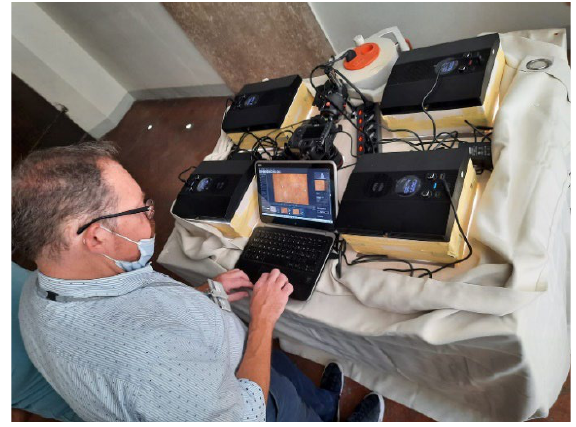
Figure 2 . the acquisition prototype in its first release with the light system, the camera and the laptop for on-site